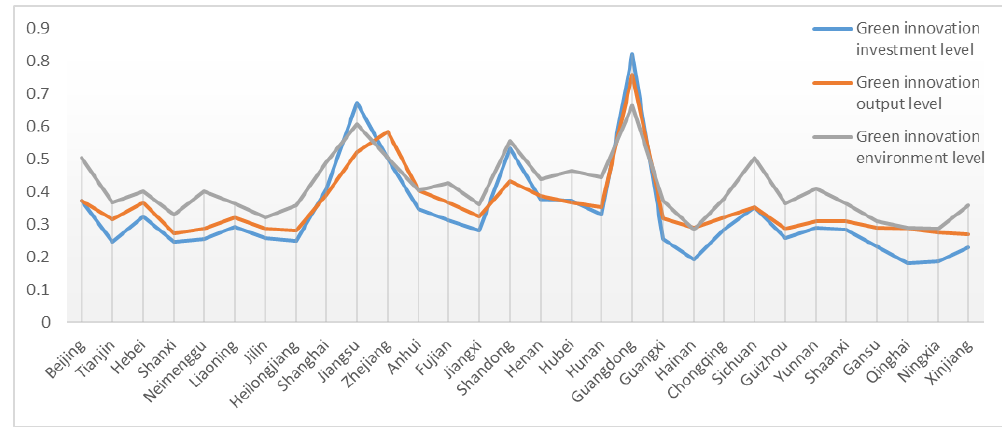
Figure 4. Comparison of the GIIL, GIOL, and GIEL.